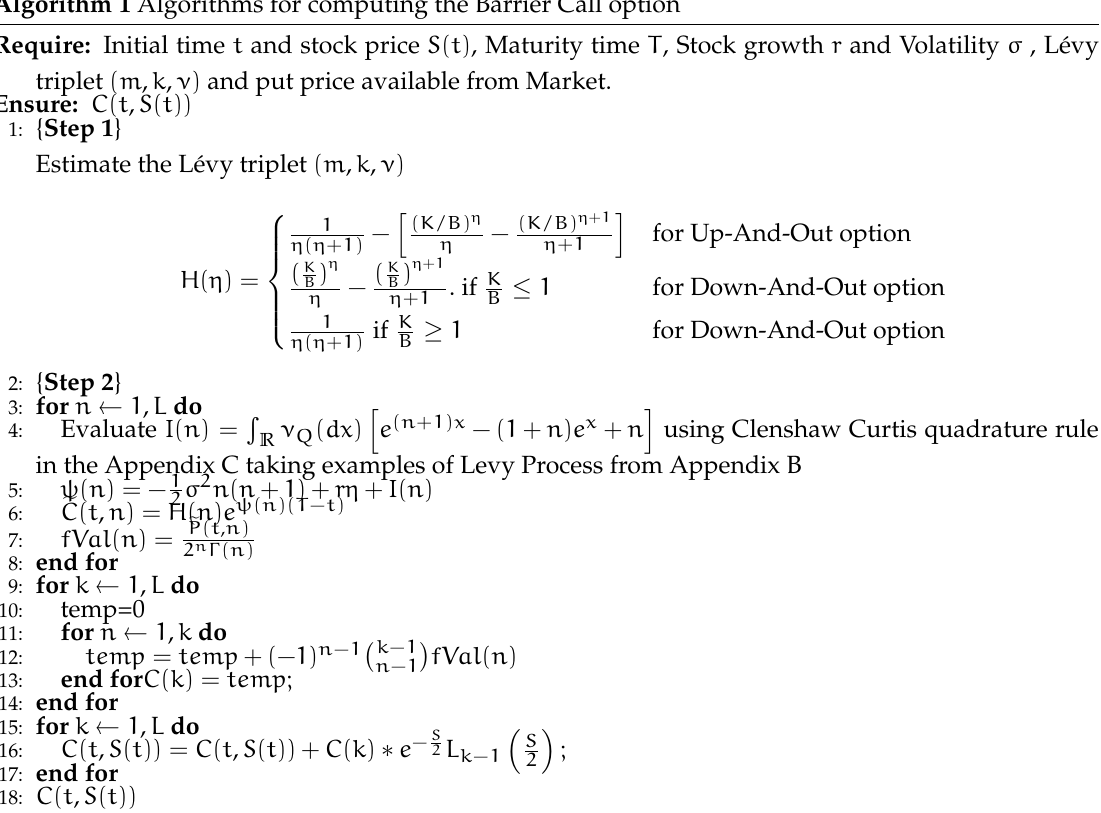
Algorithm 1 Algorithms for computing the Barrier Call